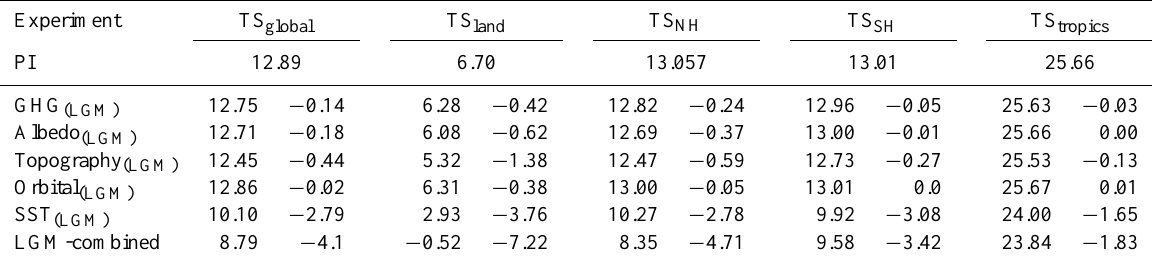
Table 3. Annual mean surface temperature (TS) in ◦ C over the globe (TS global ) , land points alone (TS land ) , Northern and Southern hemi- spheres (TS NH , TS SH ) , and tropics (TS tropics ; 20 ◦ S to 20 ◦ N) in the different experiments. The difference to the control experiment is given in the adjacent columns.